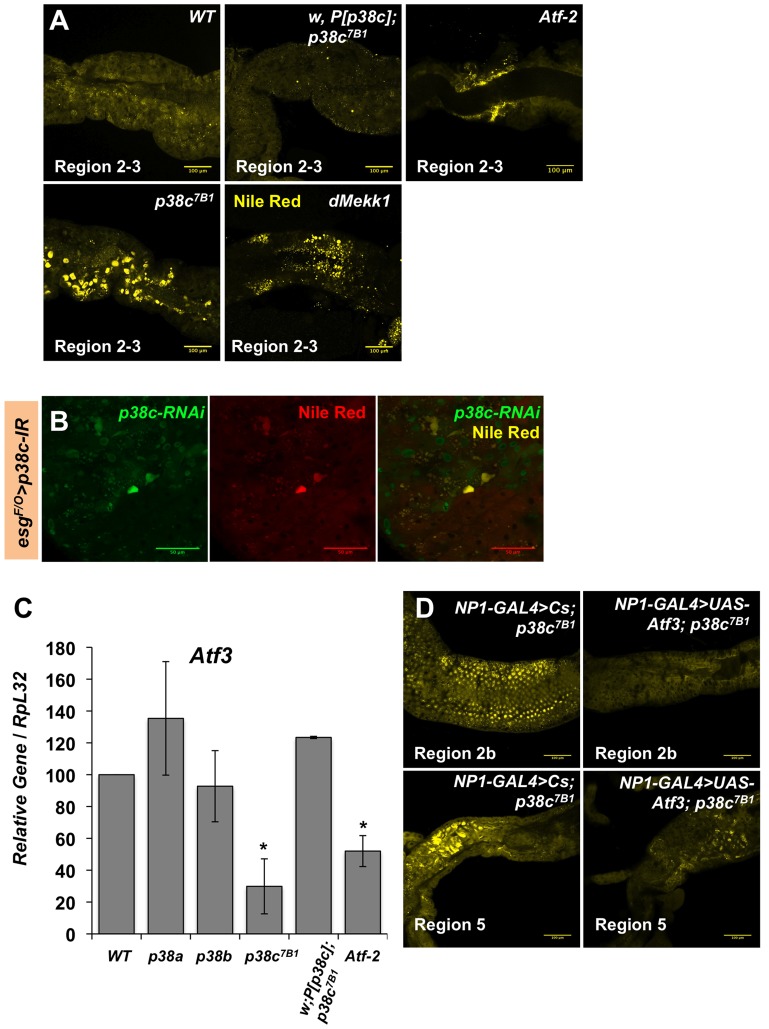
p38c and Atf3 function in a same pathway to control lipid homeostasis.(A) p38c7B1 and Mekk1Ur36 mutants accumulate lipids in regions of the midgut as observed by Nile Red. Enlarged lipid droplets were observed in the gut of p38c but not the wild-type or p38c;P[p38c] flies. Atf-2 mutants showed a modest accumulation of neutral lipids as observed by Nile Red, when compared to the wild-type. (B) A lineage tracing system using esgtsF/O to silence p38c by RNAi in specific cells. Cells with reduced p38c expression (green) had increased lipid accumulation (yellow) relative to surrounding enterocytes. (C) RT-qPCR analysis of Atf3 expression in 3–5 day old adult female fly intestines. Data are the mean of three repeats and error bars show standard error. * = p<0.05 determined by Student's t test. Genotypes are indicated on the x-axis, WT: w1118. (D) The over-expression of atf3 in p38c mutant flies (genotype: NP1-GAL4;UAS-ATF3,p38c7B1/p38c7B1) restores a wild-type level of lipid in the gut.